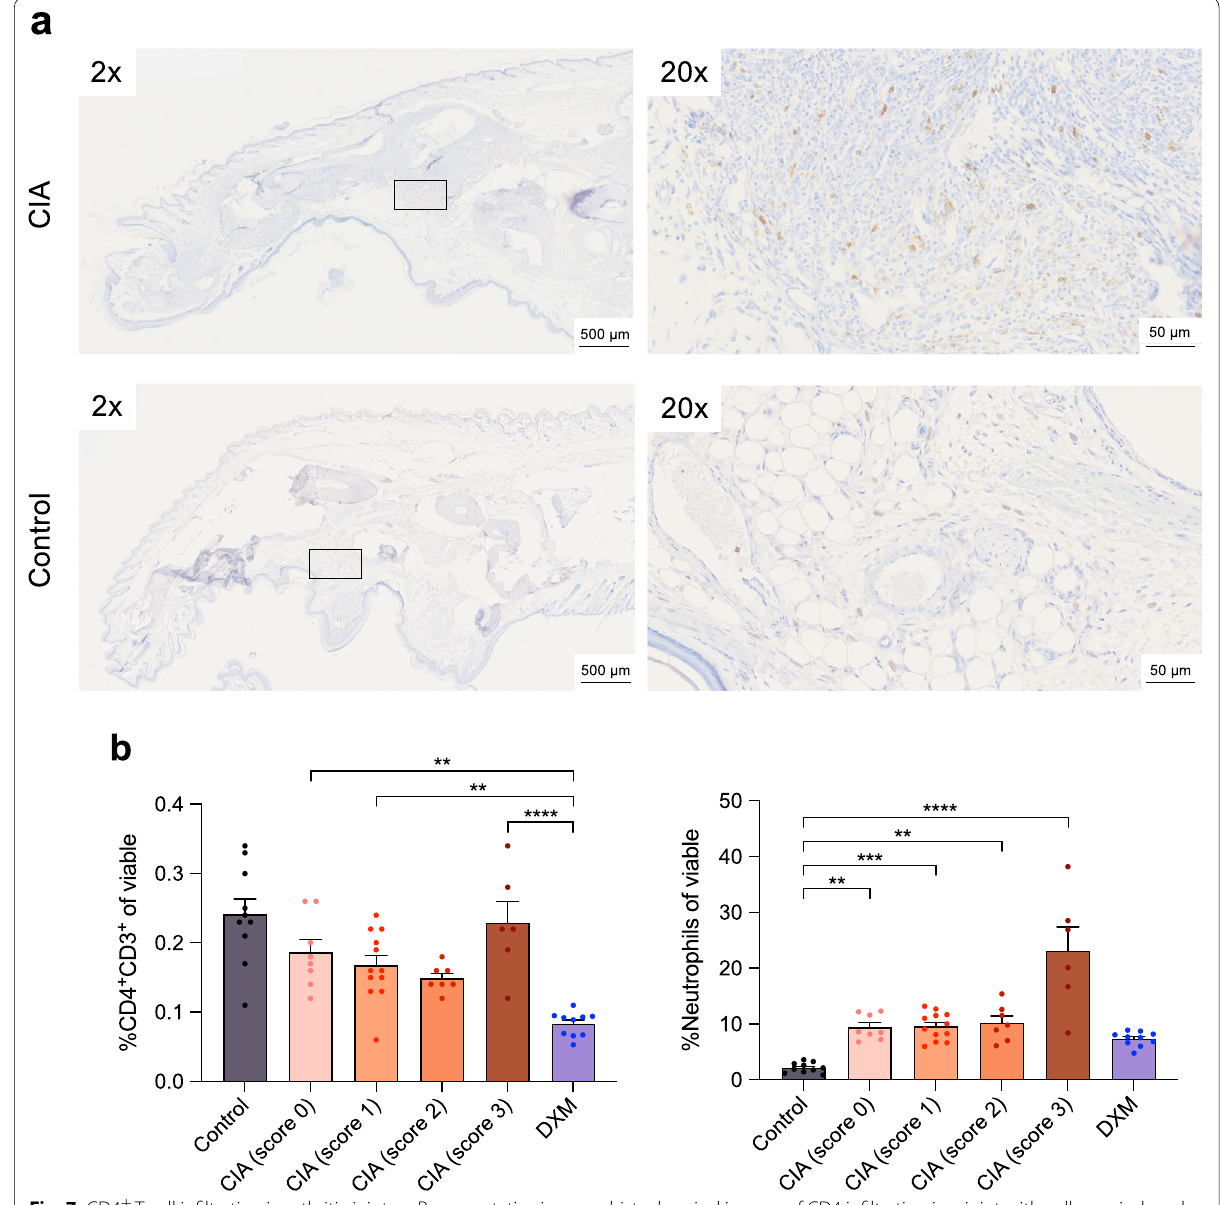
Fig. 7 CD4 + T cell infiltration in arthritic joints. a Representative immunohistochemical images of CD4 infiltration in a joint with collagen-induced arthritis (CIA) (score 3; A: upper panels) and in a joint from a control mouse (A: lower panels). Mice with CIA were scored according to degree of inflammation (swelling and erythema) in each paw on a scale from 0 to 4. b Flow cytometric analysis with infiltration of CD4 + T cells and neutrophils as percent of viable cells in the carpal and tarsal joints from control, dexamethasone (DXM) treated and untreated CIA mice. Each point represents a joint. Gating strategy is shown in Additional file 1: Fig. S2. Data are presented as mean SEM and are pooled from two independent ± experiments with similar results. The significance level is indicated by asterisks (*). p < 0.01 (**), p < 0.001 (***) and p < 0.0001